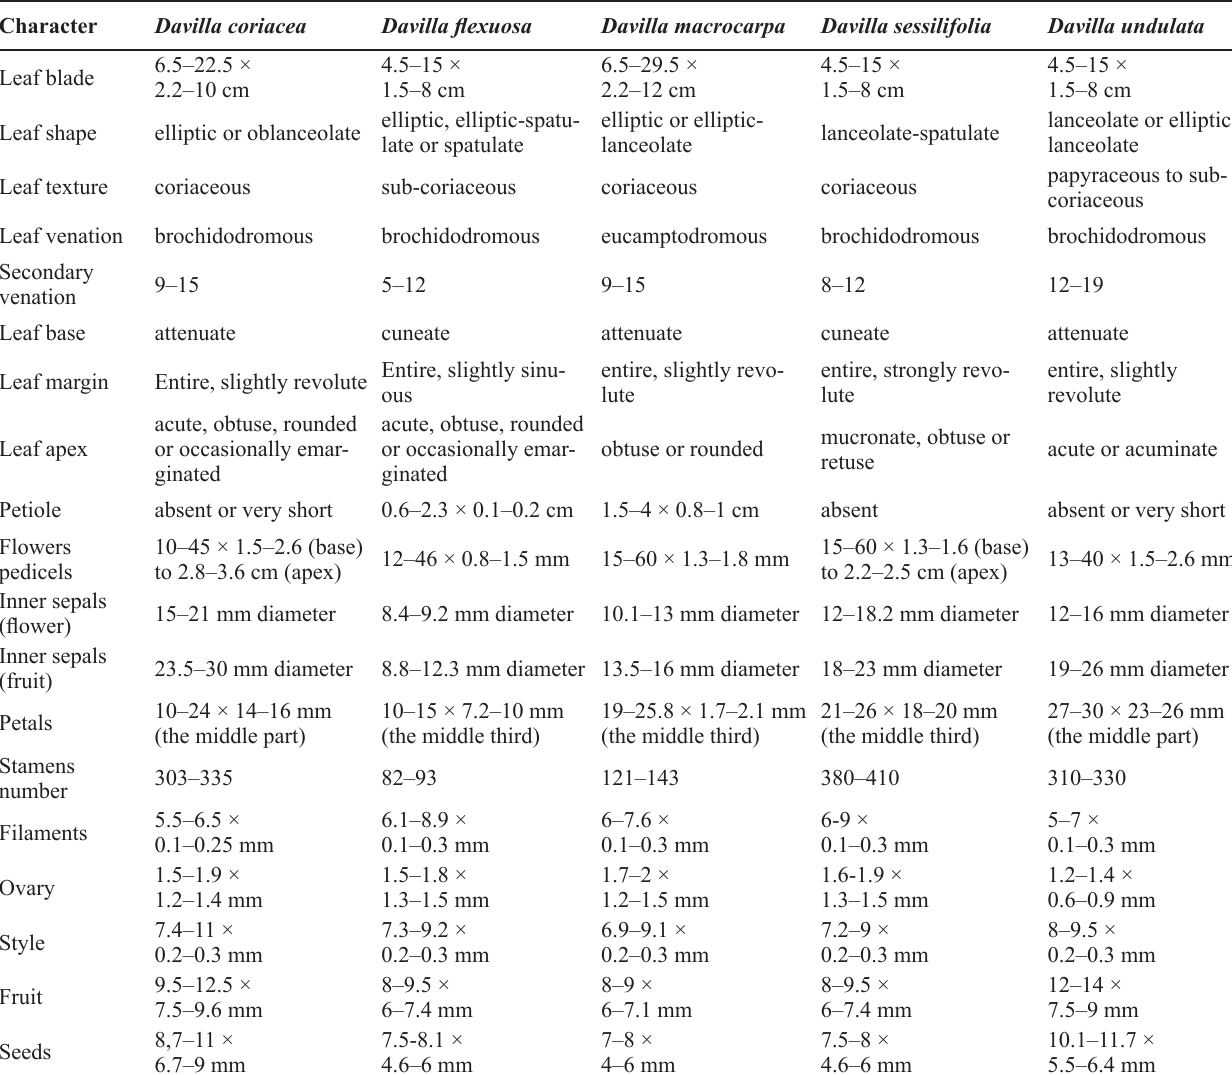
Table 1 – Key characters of the two new species Davilla coriacea and D. undulata , and comparison with their allies D. flexuosa